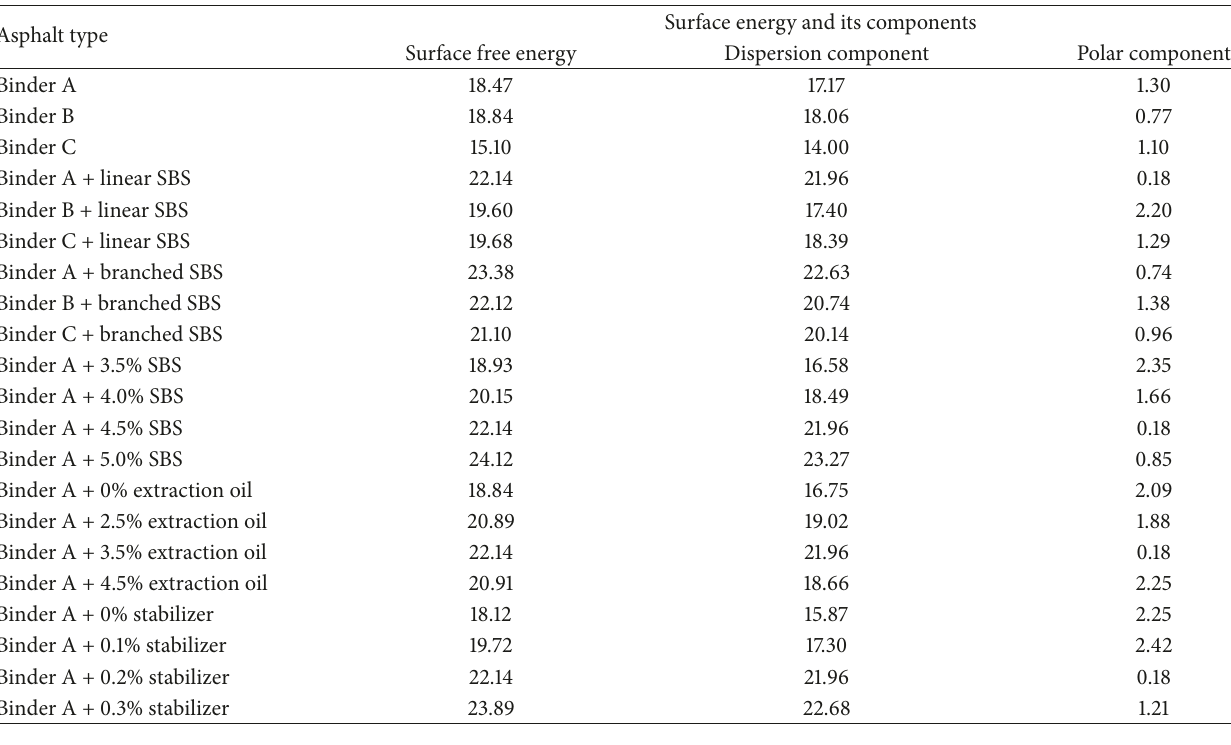
Table 7: Surface free energy of SBS-modified asphalts.